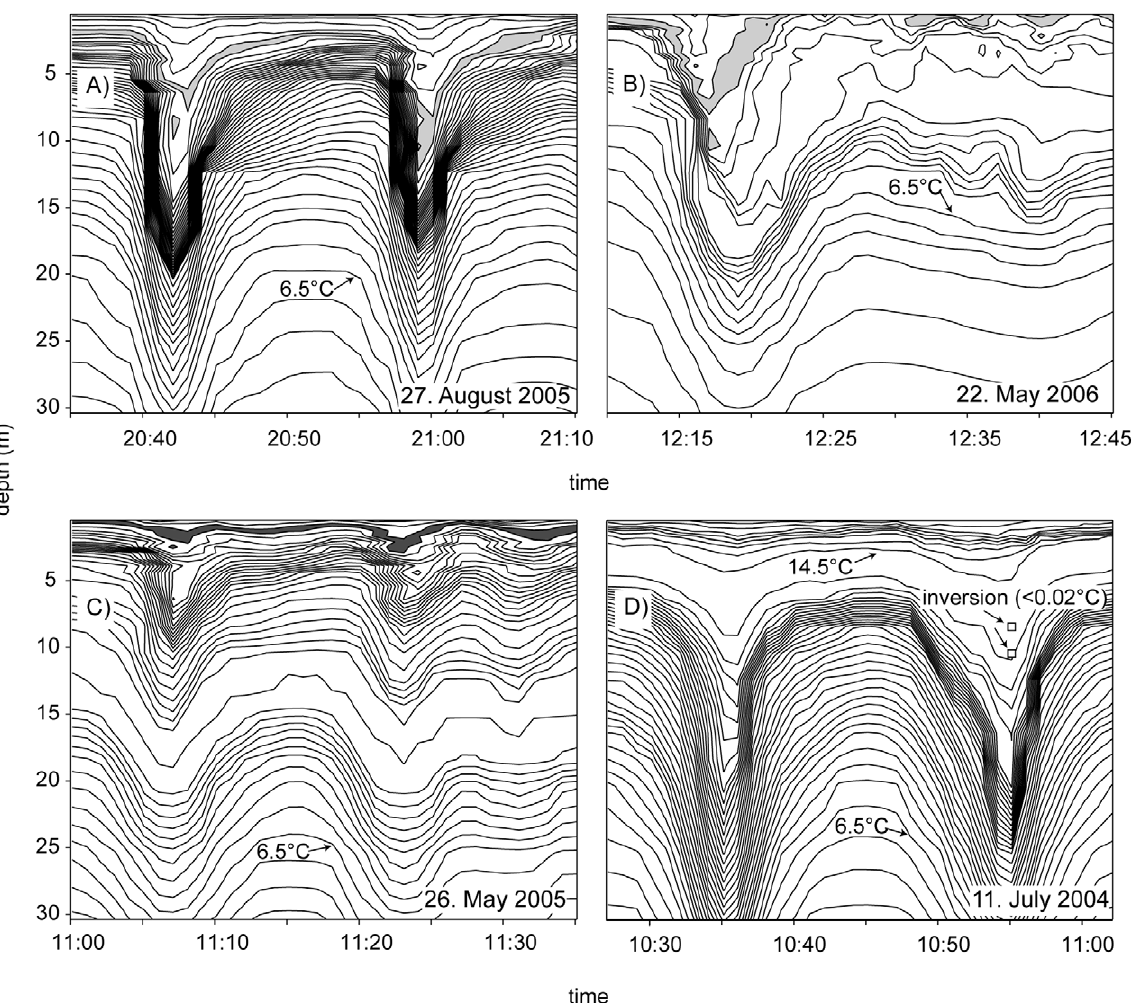
Figure 4. Measured breaking limited waves. Measured examples of (A) waves with trapped cores during autumn with a filled area between the contour-lines at 15.5 u C and 15.75 u C, (B) a wave with a perturbed trapped core during spring with a filled area between the contour-lines at 9.5 u C and 9.75 u C, (C) small waves with trapped cores during spring with a filled area between the contour-lines at 15 u C and 15.25 u C and (D) breaking limited waves without significant inversions during summer. The temperature difference spanned by the 2 m -inversion in the second wave is 0.014 u C, slightly above the accuracy range of 0.01 u C.